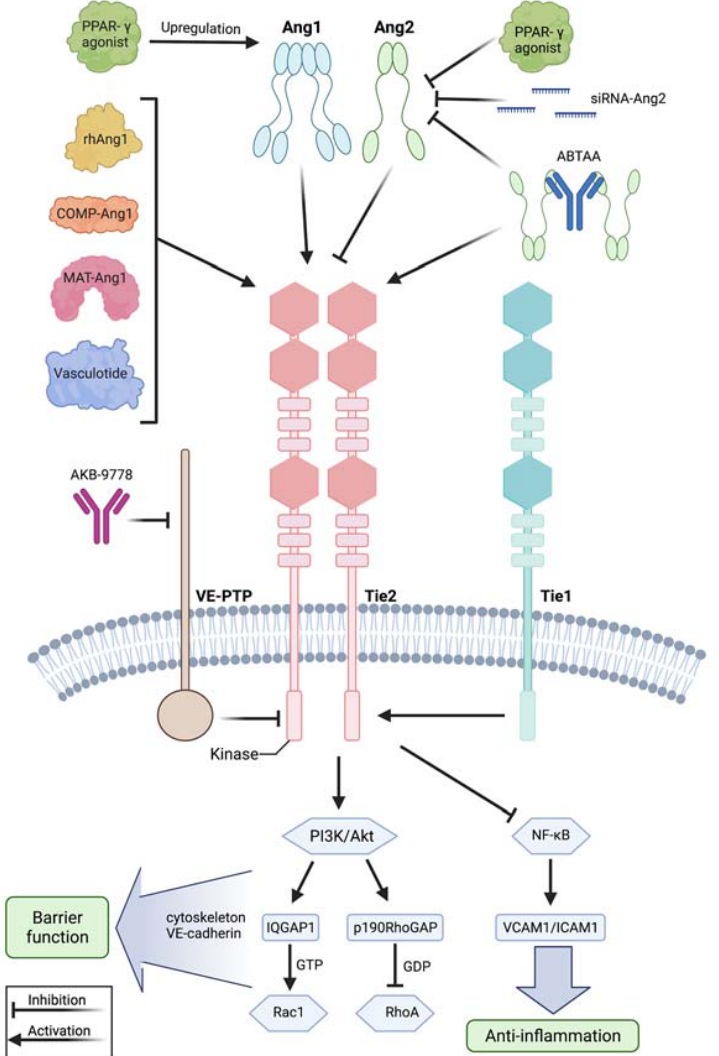
Figure 2. Modulation of the angiopoietin-Tie2 signaling axis during systemic inflammation. Recombinant human angiopoietin 1 (rhAng1), cartilage oligomeric matrix protein (COMP)-angiopoietin 1 (COMP-Ang1), matrilin-1-angiopoietin-1 (MAT-Ang1) and vasculotide are Tie2 agonists with similar action to angiopoietin 1, while peroxisome proliferator–activated receptor- γ (PPAR- γ ) agonists upregulate angiopoietin 1 bioavailability. Small interfering RNA (siRNA) against angiopoietin 2 and PPAR- γ agonists reduce angiopoietin 2 expression. AKB-9778 is an antibody directed against vascular endothelial protein tyrosine phosphatase (VE-PTP) and thus indirectly activates Tie2. ABTAA is a novel ANG2-binding and Tie2-activating antibody combining the features of angiopoietin 2 inhibition and Tie2 activation. Tie1 further modulates response at the Tie2 receptor as endothelial cells shed the Tie1 ectodomain leading to Ang2 binding, resulting in Tie2 antagonism and reducing the agonistic activity of Ang1 during inflammation. Mechanistically, these treatment strategies lead to Tie2 receptor agonism, resulting in enhanced vascular barrier function by the PI3K/Akt signaling cascade and anti-inflammation by suppression of transcription factor NF- κ B and, thus, of intercellular adhesion molecule (I-CAM) and vascular cell adhesion molecule (V- CAM). Downstream of phosphatidylinositol-3-kinase/protein kinase B (PI3/Akt) activation, there is the GTPase-activating protein 1 (IQGAP1), which activates Rac1 by stabilizing it in its active GTP- bound form, whereas Rho GTPase-activating protein p190RhoGAP converts RhoA into its inactive state. These steps promote an increase in cortical actin that strengthens the cytoskeleton and thus the vascular barrier function, whereas Tie2 activation additionally results in inhibition of Src kinase preventing the phosphorylation and internalization of vascular endothelial-cadherin (VE-cadherin). This figure was created with BioRender.com and adapted from Pariksh SM et al., J Am Soc Nephr 2017 and Wettschureck et al., Physiol Rev 2019 [36,74].